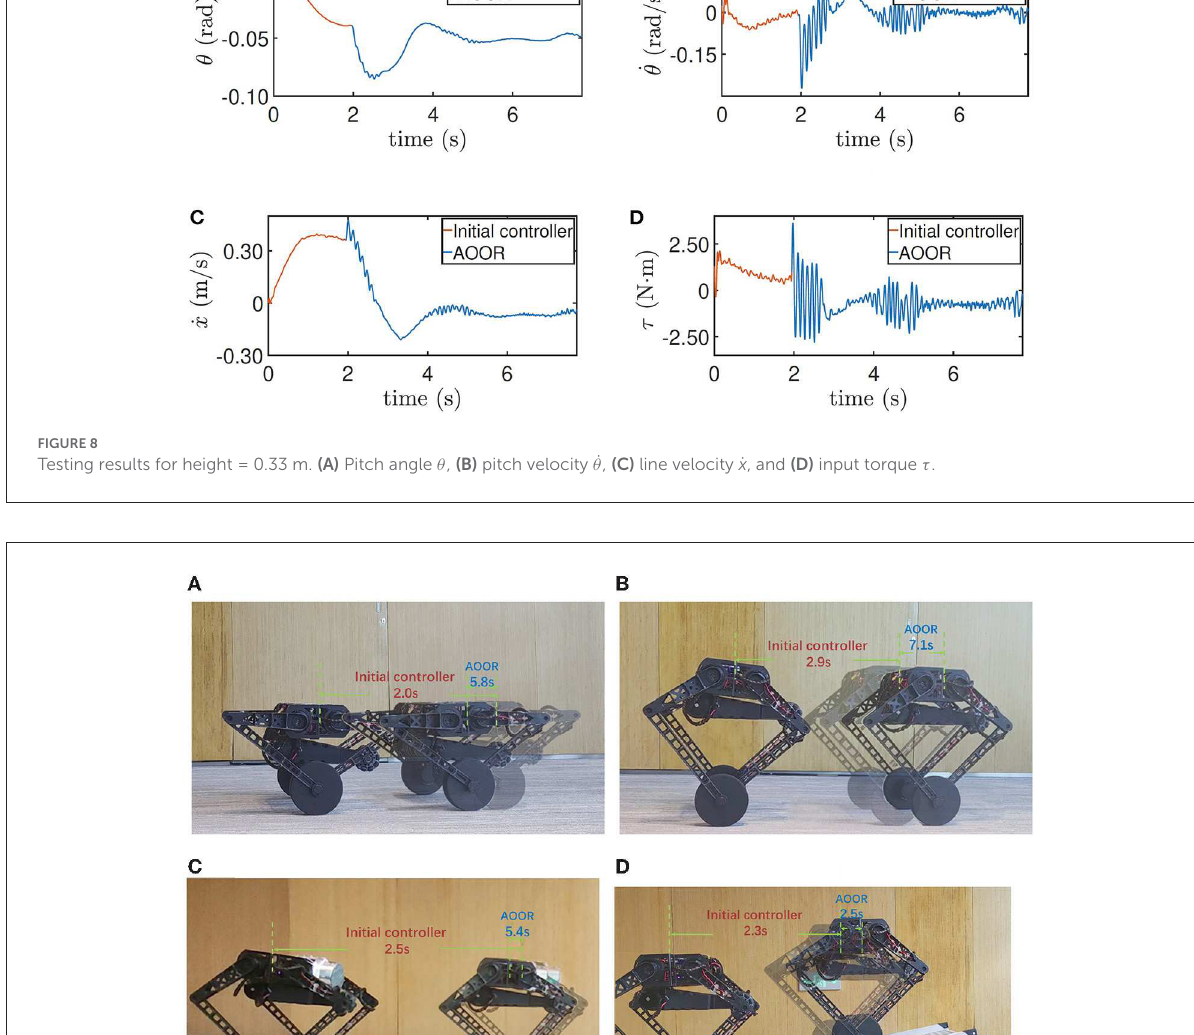
including the deceleration phase, is demonstrated in Figures 9B, C